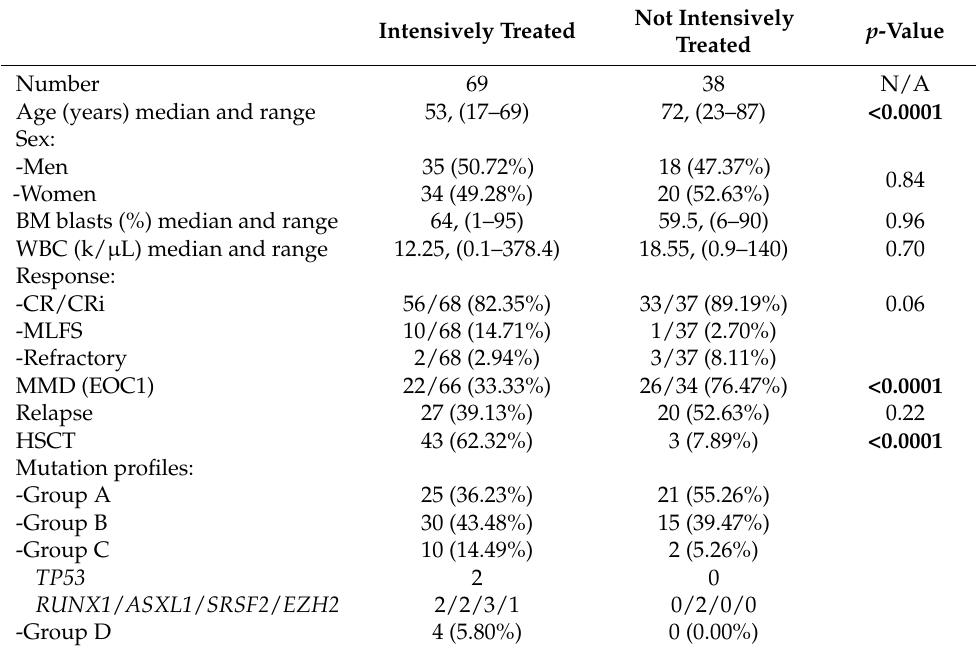
Table 1. Summary of clinicopathological features of the total study